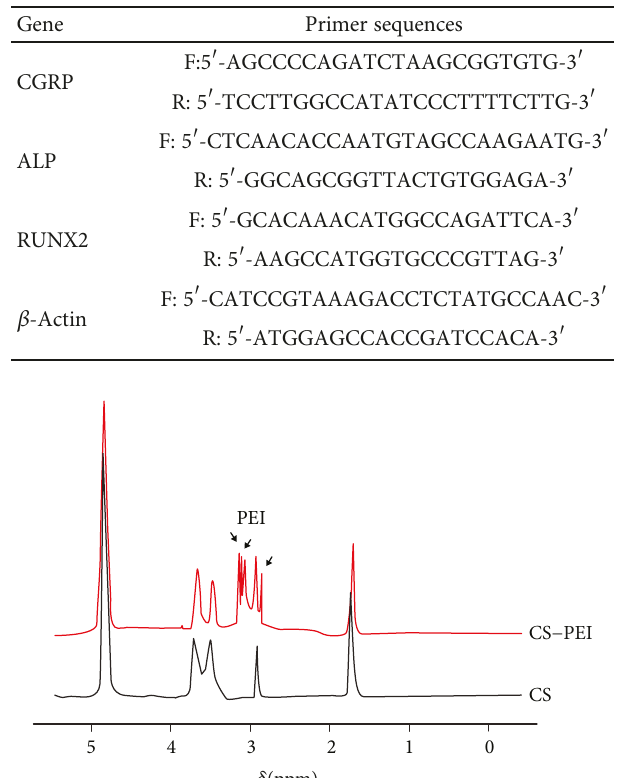
Table 1: PCR primer sequences.